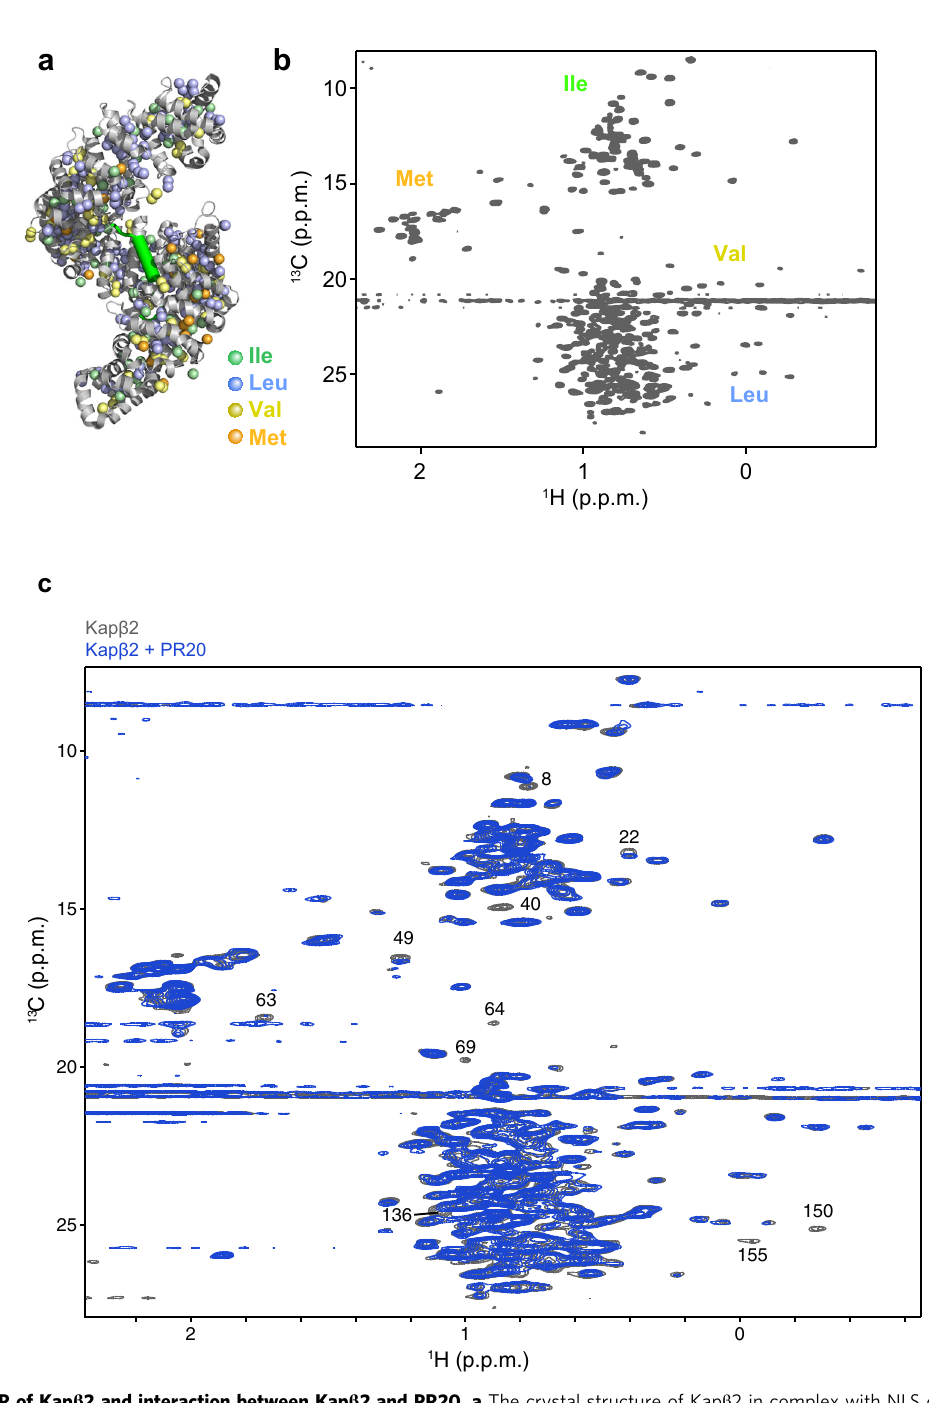
Fig. 3 Solution NMR of Kap β 2 and interaction between Kap β 2 and PR20. a The crystal structure of Kap β 2 in complex with NLS of FUS. NLS of FUS is presented as a green cylinder and Kap β 2 is shown as a gray ribbon, with spheres representing methyl groups of Ala (pink), Ile (green), Leu (blue), Val (yellow), and Met (orange). Kap β 2 is enriched in methyl-baring residues, indicating that suf fi cient information can be collected from the 1 H- 13 C-correlated resonances of Ile, Met, Val, and Leu methyl groups are labeled. c Interaction between Kap β 2 and PR poly-dipeptide investigated by solution NMR. 1 H- β 2 in the absence (gray) and presence (blue) of PR20. 13 C-correlated methyl NMR spectra of [U- 2 H; Ile- δ 1- 13 CH 13 CH 12 CH 3 ; Leu, Val- 3 / 3 ]-labeled Kap Signi fi cant perturbations were observed for several resonances, indicating that PR poly-dipeptides bind to speci fi c region(s) of Kap β 2. The perturbed resonances are indicated by peak numbers. The peak numbering corresponds to those in Supplementary Fig.